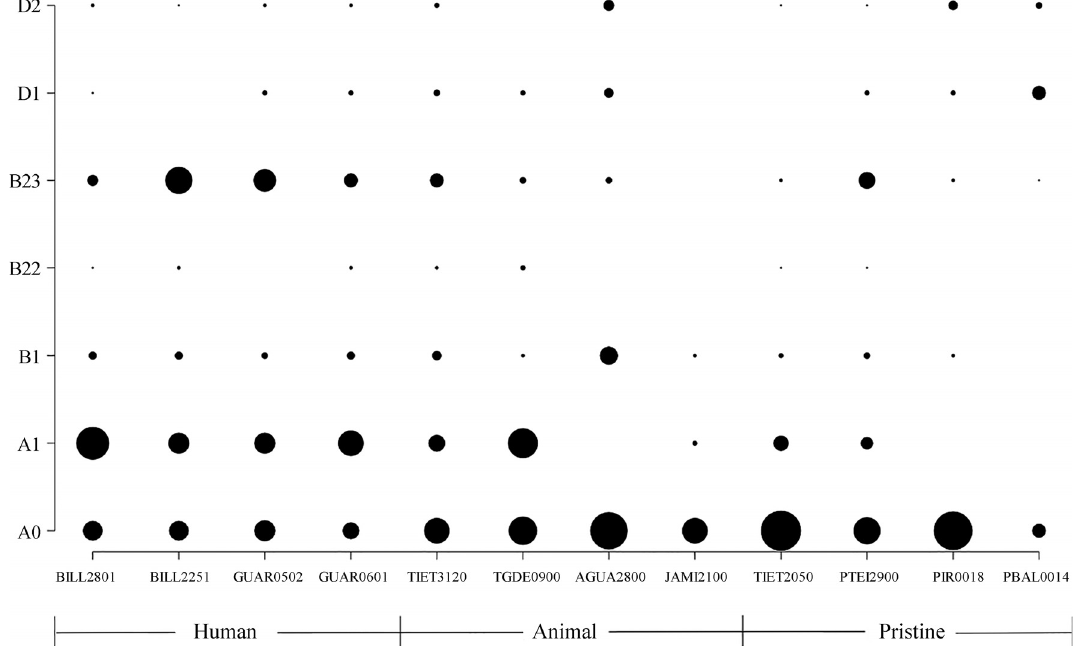
Figure 2 - Distribution of E. coli phylogenetic subgroups in rivers and reservoirs. The circle size is proportional to phylogenetic subgroup